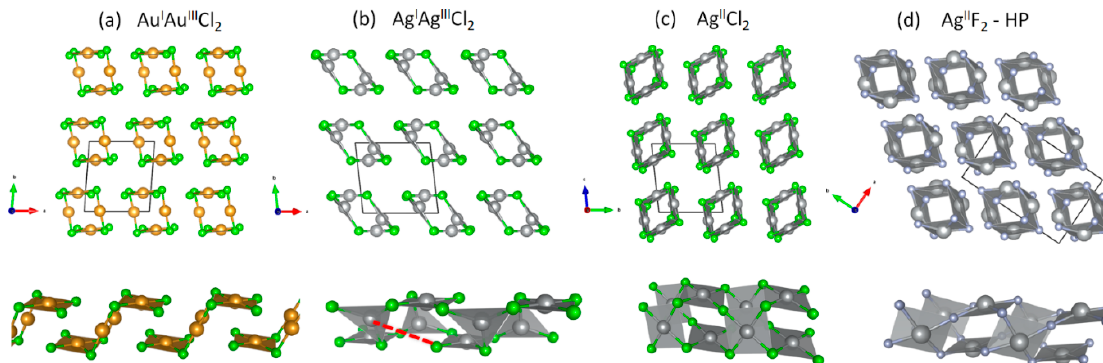
Figure 8. Crystal structure of Au(I)Au(III)Cl 4 ( a ), AgCl 2 optimized in the Au(I)Au(III)Cl 4 structure ( b ), AgCl 2 optimized in the Au(I)Au(III)Cl 4 structure with the symmetry-enforced comproportionation Ag I Ag III → Ag II Ag II ( c ) and high-pressure polymorph of AgF 2 ( d ). Top view: stacking of the chains, bottom view: connectivity within single chain.